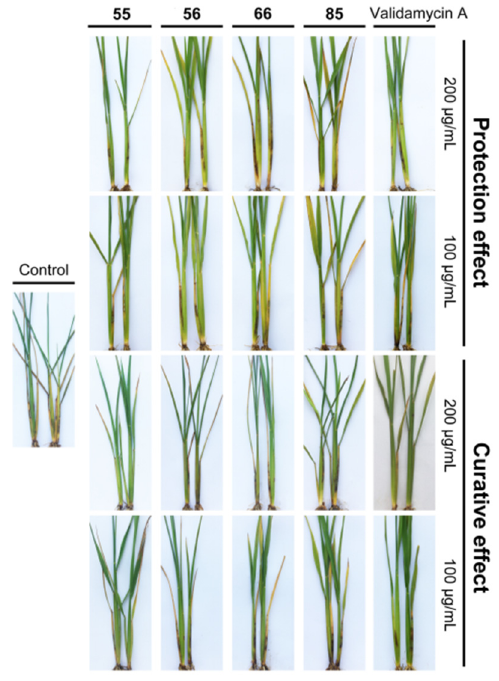
Figure 4. In vivo protective and curative activities of selected compounds against R.